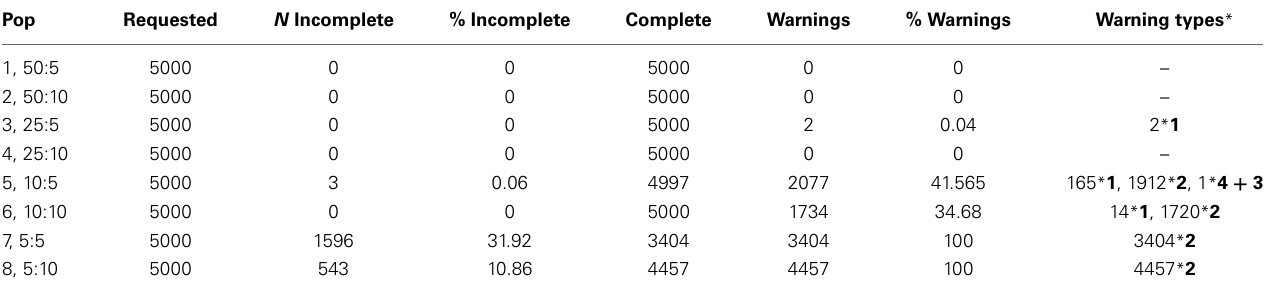
Table 2 | Convergence in the simulation study with ML estimation. Pop